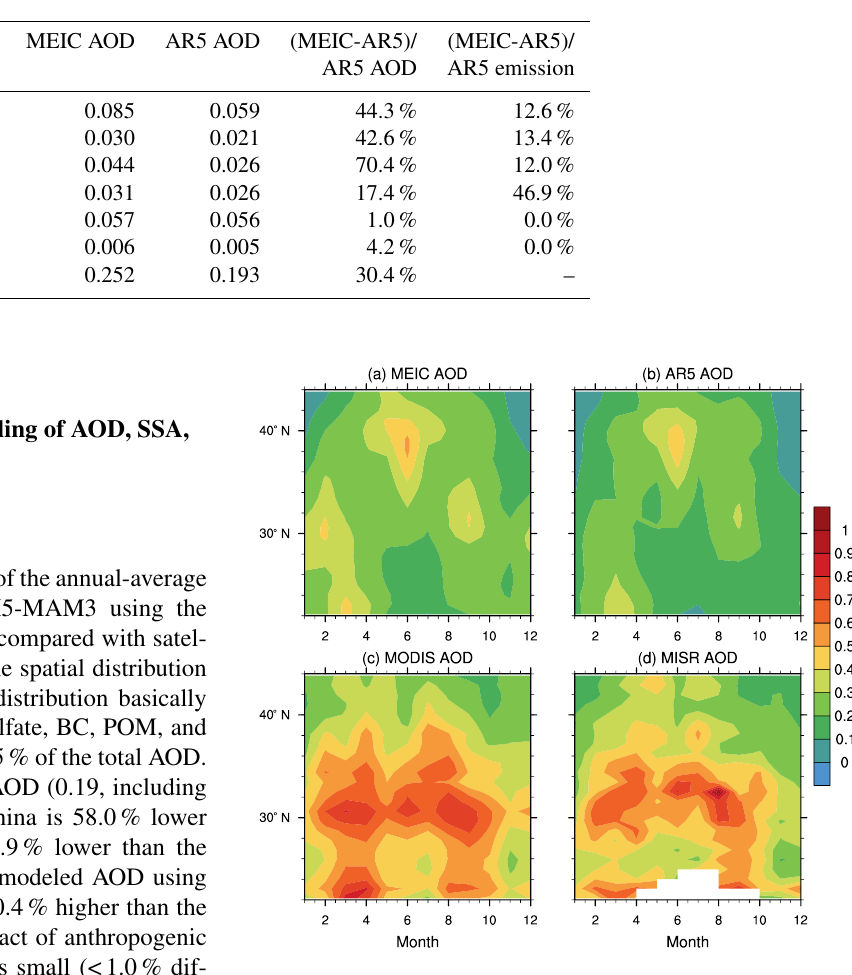
Table 1. AOD averaged over eastern China in 2009 simulated using the MEIC and the AR5 emissions.